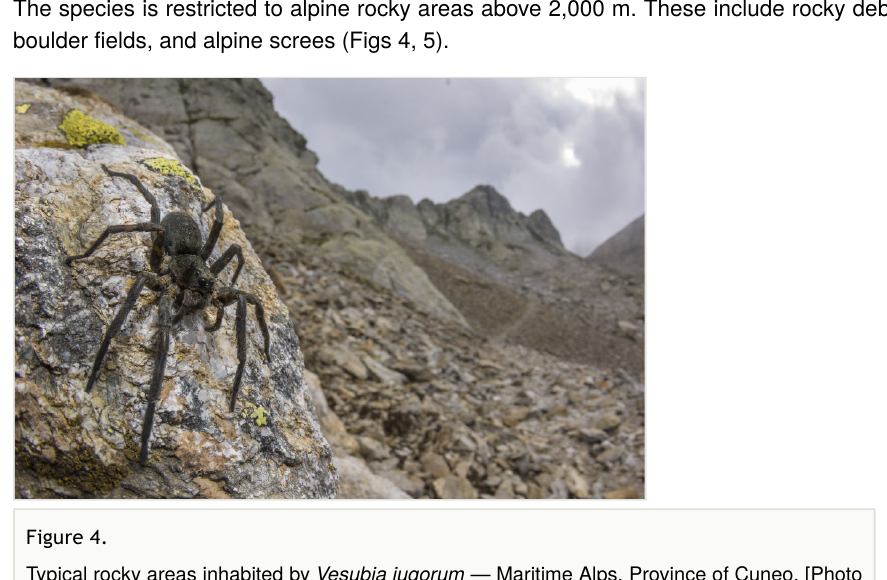
Typical rocky areas inhabited by Vesubia jugorum — Maritime Alps, Province of Cuneo. [Photo credit: Emanuele Biggi,